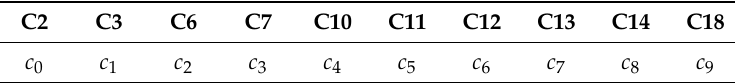
Table 4. The Encoding of Breakers.